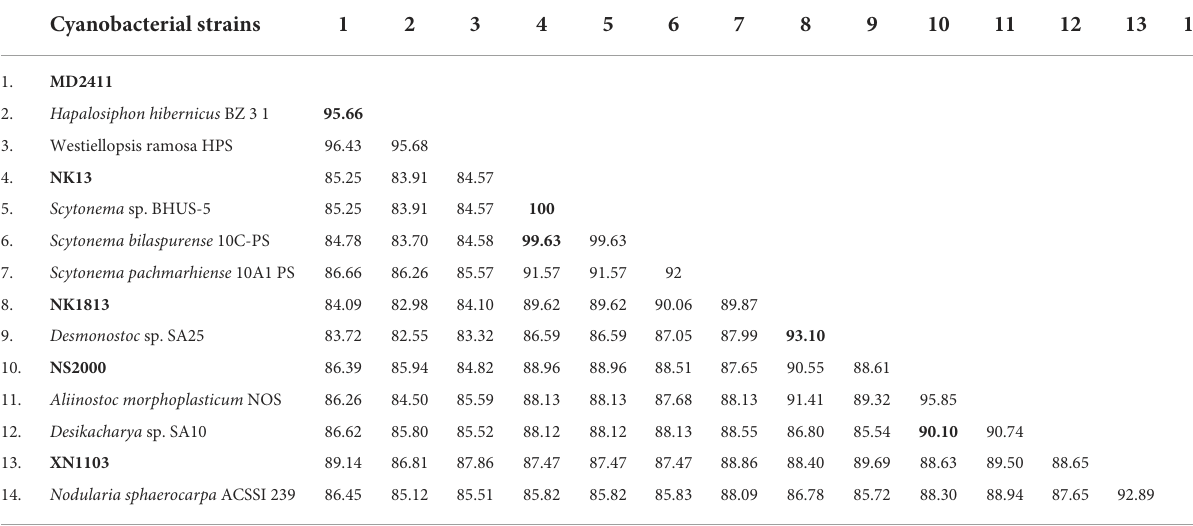
TABLE 3 Percentage identities of the rbc L gene region between isolated strains described in this study and other most related strains from GenBank. Cyanobacterial strains